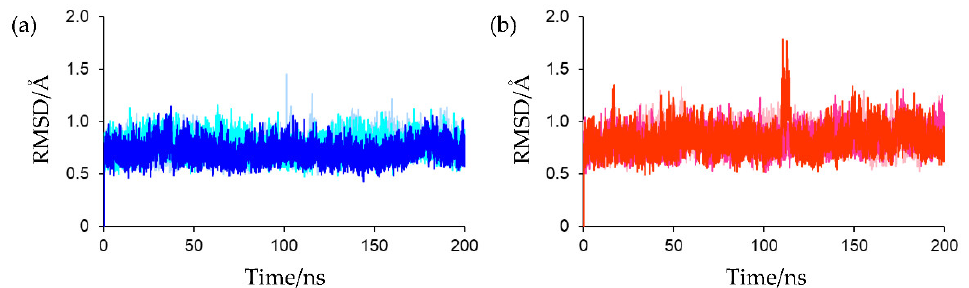
Figure 3. ( a ) RMSD plots of protein backbone for oxidized Fd. RMSD plots of the first, second, and third simulations were presented in light blue, cyan, and blue, respectively. ( b ) RMSD plots of protein backbone for reduced Fd. RMSD plots of the first, second, and third simulations were presented in light pink, magenta, and red, respectively.